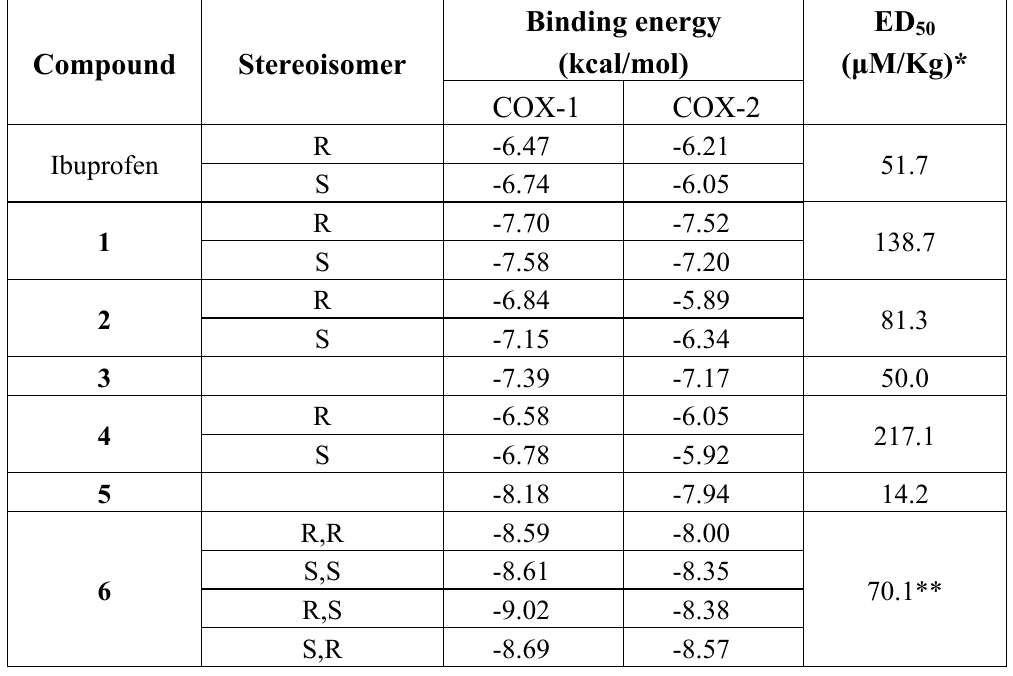
Table 1 . Binding energies of top scored solutions as resulting from docking experiments, and corresponding standard biological response of studied compounds.